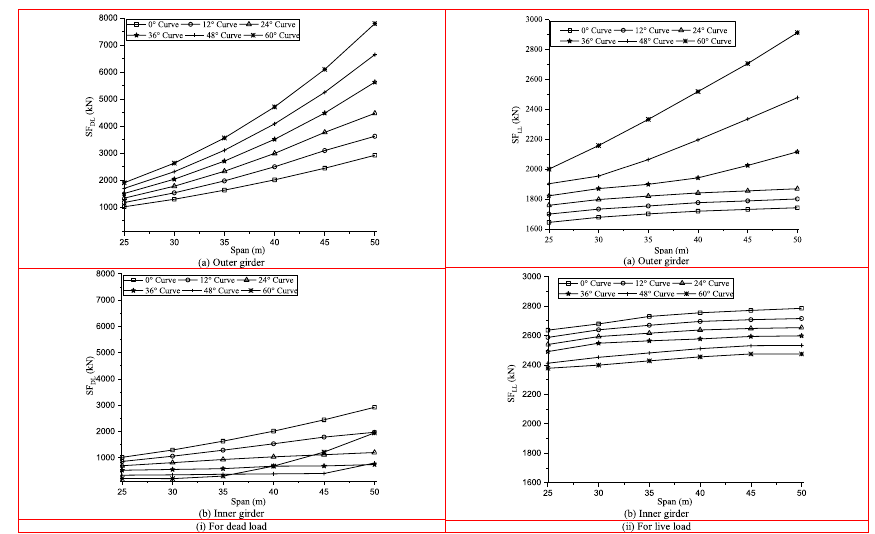
Fig. 14 Variation of shear force with span for different curve angle. a Outer girder. b Inner girder. (i) For dead load. (ii) For live load